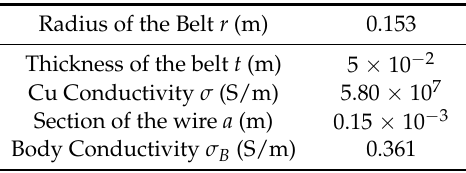
Table 1. Main parameters of the